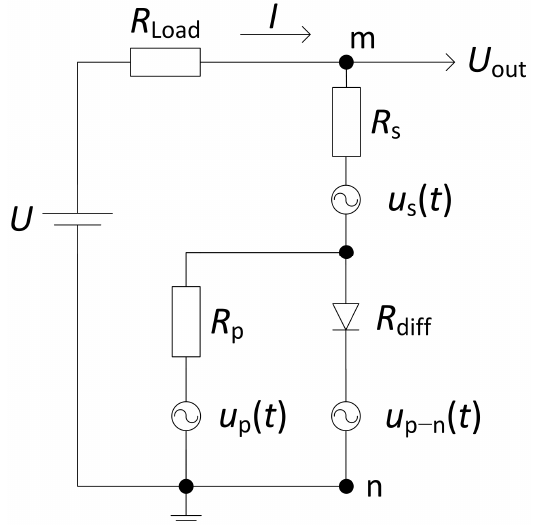
Figure 1. Equivalent electrical circuit of LED with voltage noise sources ( R Load >> R mn ).